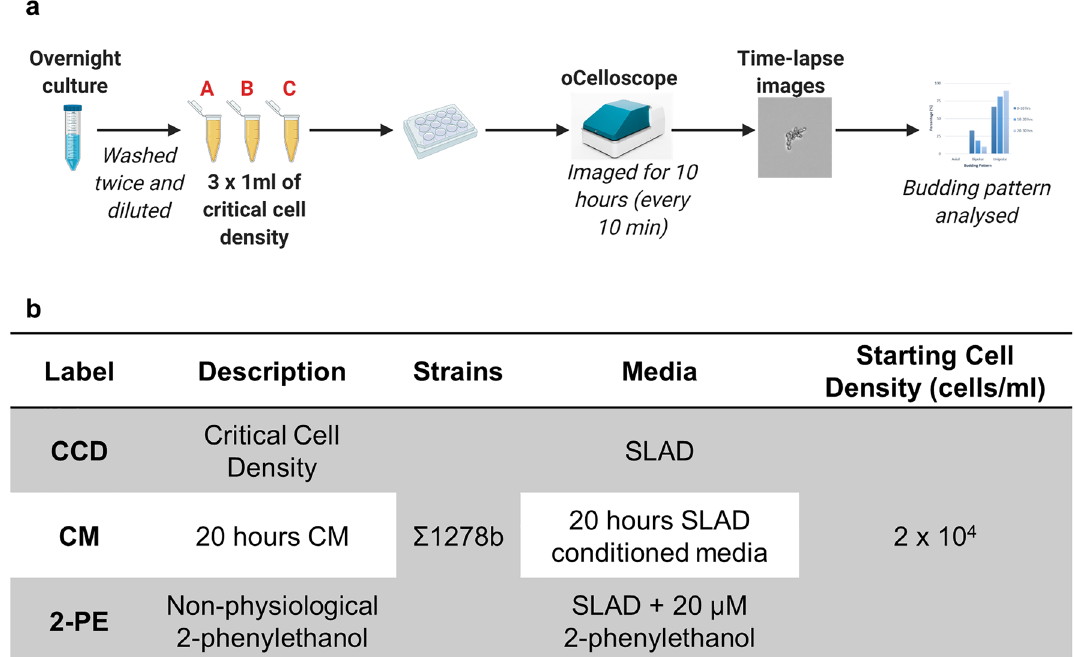
Figure 7. The factors responsible for change in budding pattern were investigated under low nitrogen conditions using strain Σ1278b. ( a ) Schematic diagram of experimental set-up. ( b ) Experimental conditions used included the critical cell density (CCD), 20 h conditioned media (CM), and media with a high concentration of 2-phenylethanol (2PE). All conditions inoculated cells at the critical cell density 2 × 10 4 cells/